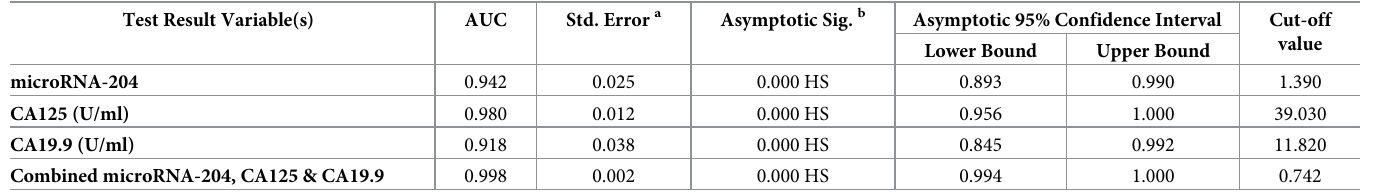
Table 5. Area under the curve (AUC) and a cut-off value of microRNA-204, CA125, CA19.9, and combined microRNA-204, CA125, and CA19.9 in late ovarian can- cer patients. Test Result